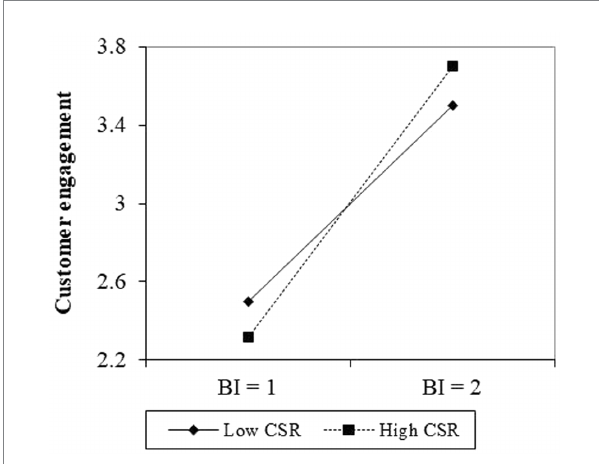
FIGURE 2 Moderating effects of corporate social responsibility on the relationship between brand image and customer engagement.